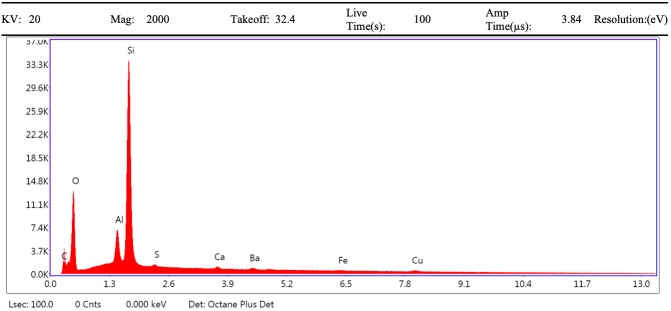
EDS spectrum of vessel interior (region 2) from demineralised Late Cretaceous Centrosaurus bone area D.